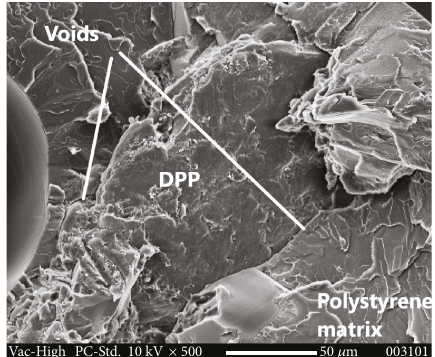
Figure 2: SEM of 20-DPP composite.